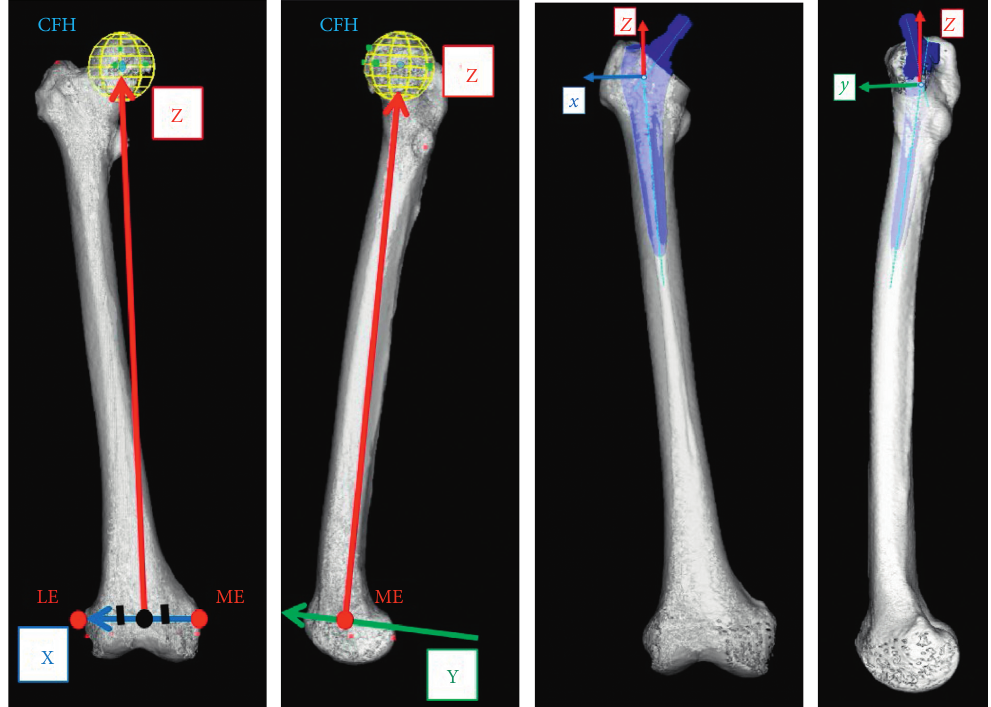
Figure 2: The femoral coordinate system recommended by the International Society of Biomechanics (ISB). The origin (black point) coincident with the middle point of the medial femoral epicondyle (ME) and lateral femoral epicondyle (LE). Y -axis: the line perpendicular to the X -axis and the CT coordinate system Z -axis and passing through the origin. Positive direction is from the posterior to the anterior of the pelvis. Z -axis: A straight line perpendicular to the X and Y axes. Positive direction is from the inferior to the su- perior aspect of the pelvis.